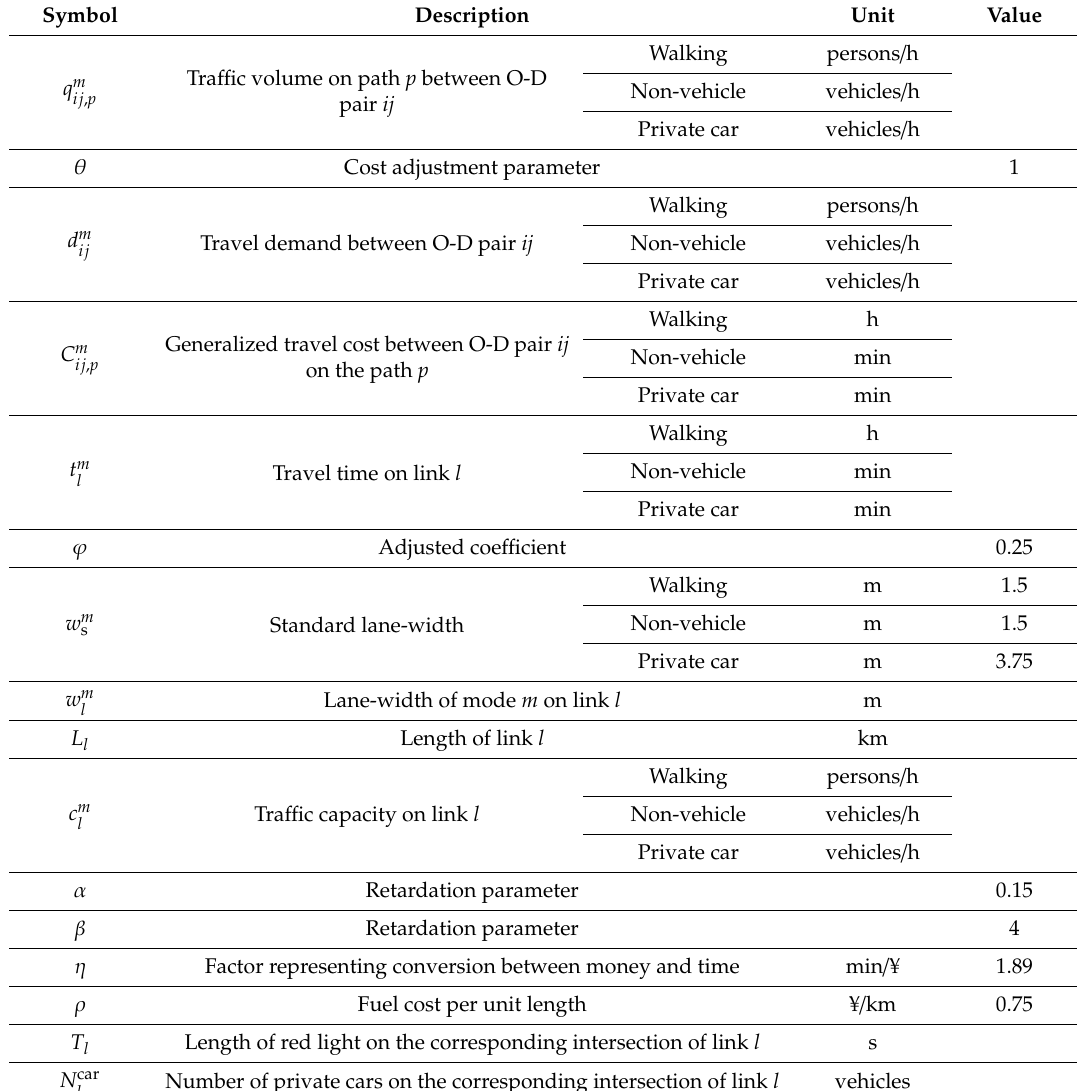
Table 2. Relevant variable units and parameter